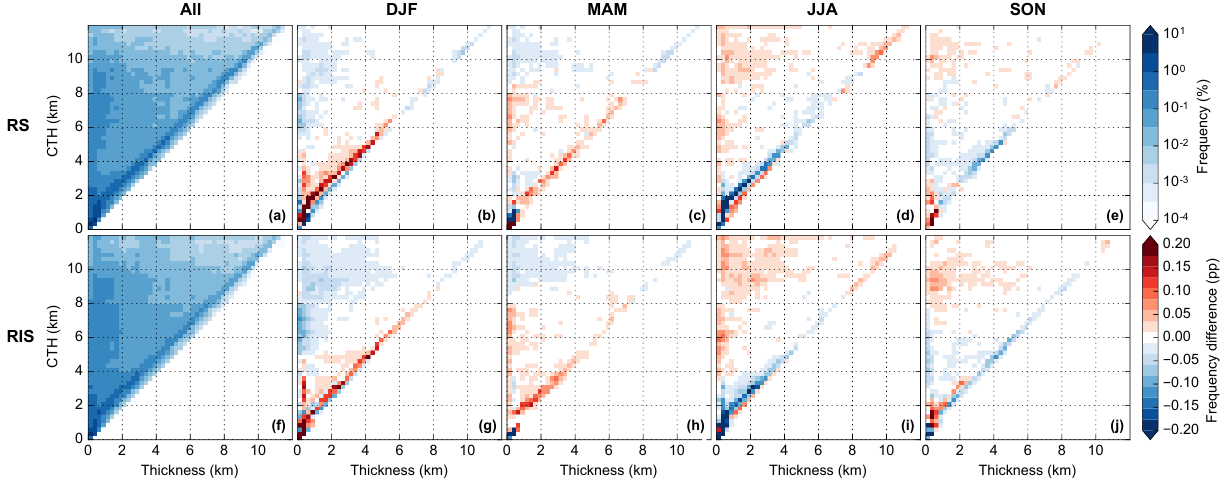
Figure 8. Joint histogram of the cloud top height vs. geometric cloud thickness over the Ross Sea and RIS for the entire year on a logarithmic scale (a, f) and the difference from the annual mean over the respective region (RS and RIS) for each season on a linear scale (b–e, g–j)